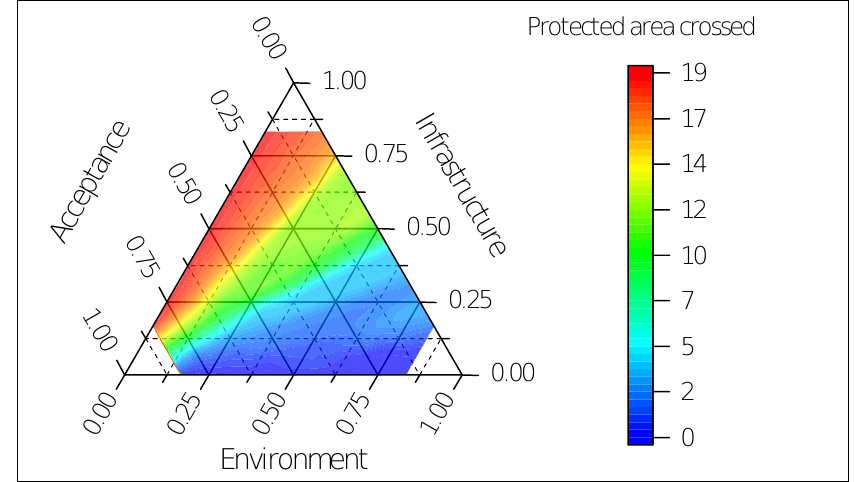
Figure A3. Influence of different weighting factors on the protected areas crossed for the DC SWE/FIN project. Own illustration.